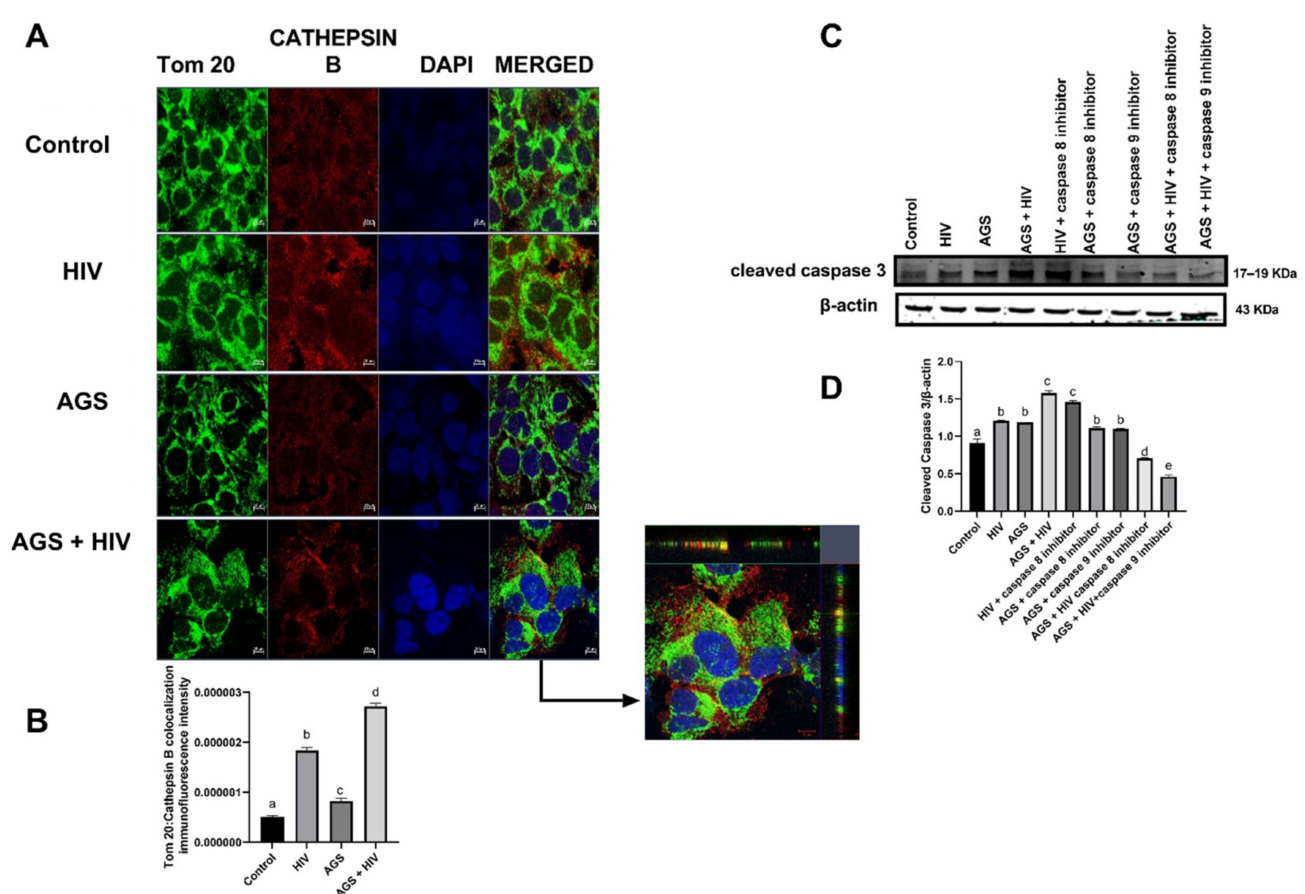
Figure 4. AGS and HIV enhance cathepsin B-triggered caspase 3-dependent apoptosis (RLW cells were treated as described in Materials and Methods) ( A , B ) Immunofluorescence detection of co-localization of Cathepsin B and Tom20 and quan- tification of staining. Staining was visualized using a 40 × lens in LSM 710 confocal microscope, and staining intensity was quantified using NIH ImageJ. ( C , D ) Cleaved caspase-3 was measured by immunoblot analysis and quantification of immunoreactive bands from 3 independent experiments. Data are from 3 independent experiments presented as mean values ± SEM. Bars marked with the same letter are not significantly different from each other; bars with different letters are significantly different from each other ( p ≤